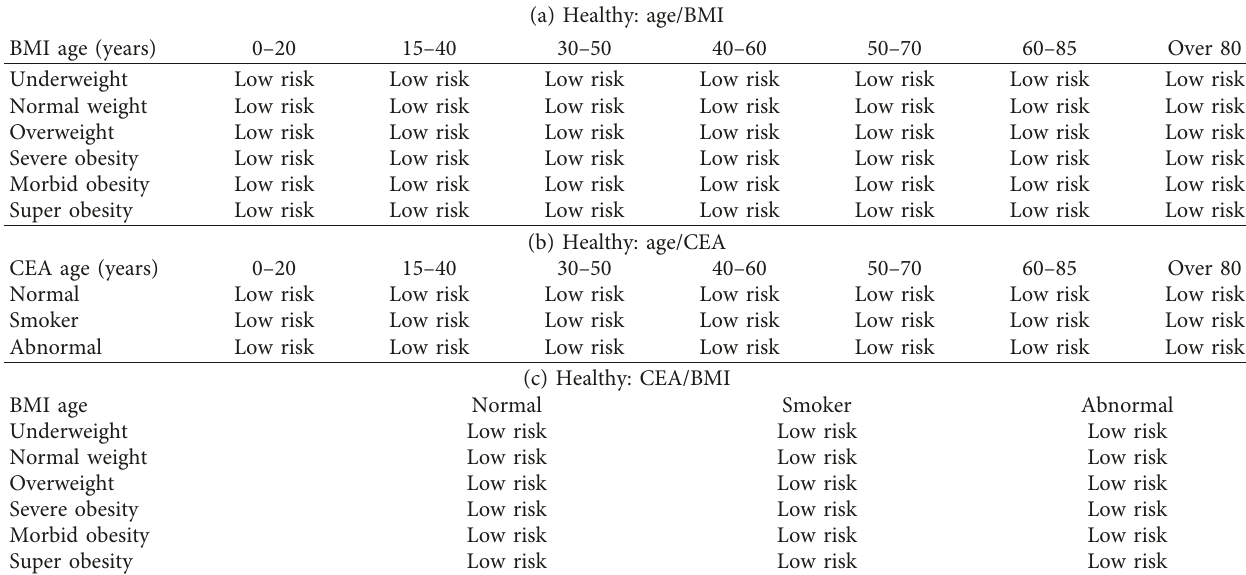
Table 3: Risk of tumor. (a) Healthy: age/BMI; (b) age/CEA; (c)